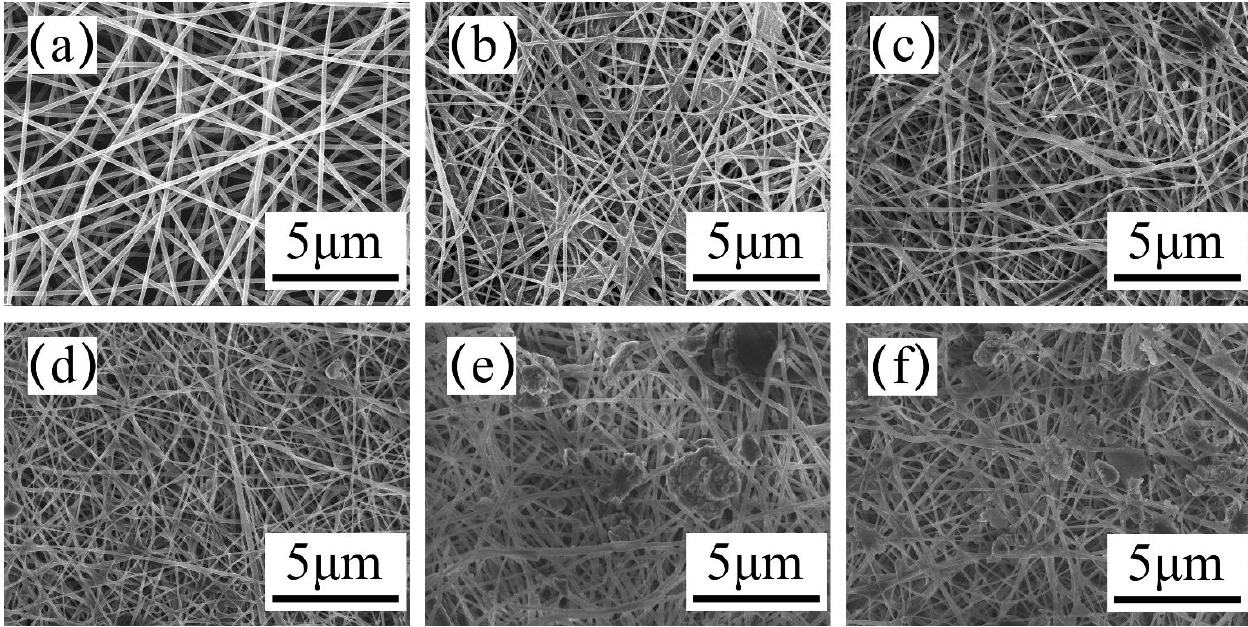
Figure 2. SEM micrographs for the surface of electrospun PAN separator and composite separator with different ZSM-5 concentrations: ( a ) PAN, ( b ) Z/PAN-0, ( c ) Z/PAN-0.5, ( d ) Z/PAN-1, ( e ) Z/PAN-1.5 and ( f ) Z/ PAN-2.